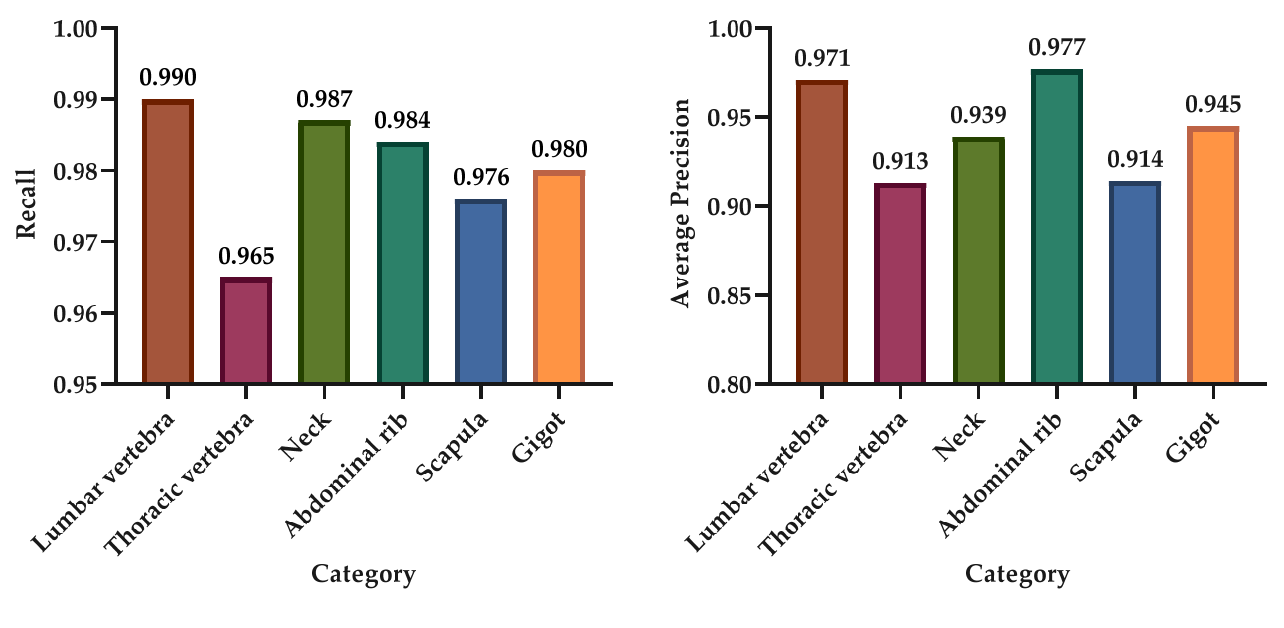
( c ) Sample 3 Figure 10. Partial detection results of the model based on Swin-T mu tt on multi-parts classi fi cation detection. Under the background of the current mu tt on processing technology, the mu tt on parts fall on the conveyor belt in a periodic and intermi tt ent manner, forming a region, which is manifested as a single image containing multiple, multi-class, and repeated mu tt on parts, as shown in Figure 10. In Figure 10a–c, the detection of various types of mu tt on parts does not appear to be incomplete or incorrect; all the categories of each mu tt on com- ponent can be detected with a high degree of con fi dence. Meanwhile, the bounding box marking area is correct and complete, especially the relatively small scapula in sample 2